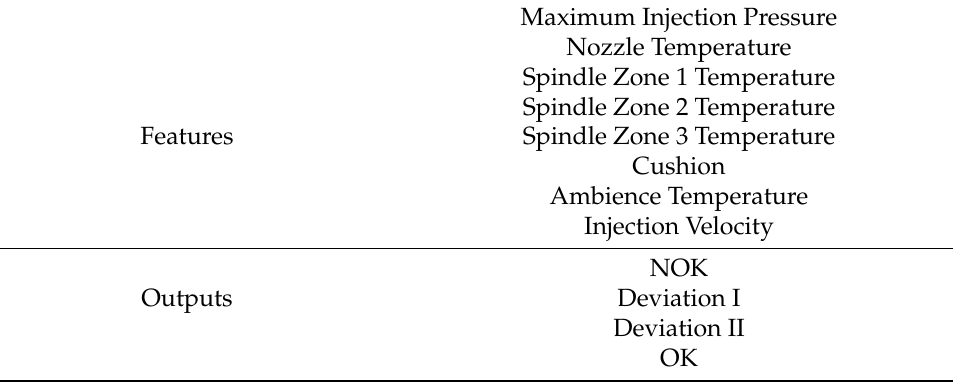
Table 5. Features and Labels of the Negri Bossi dataset.